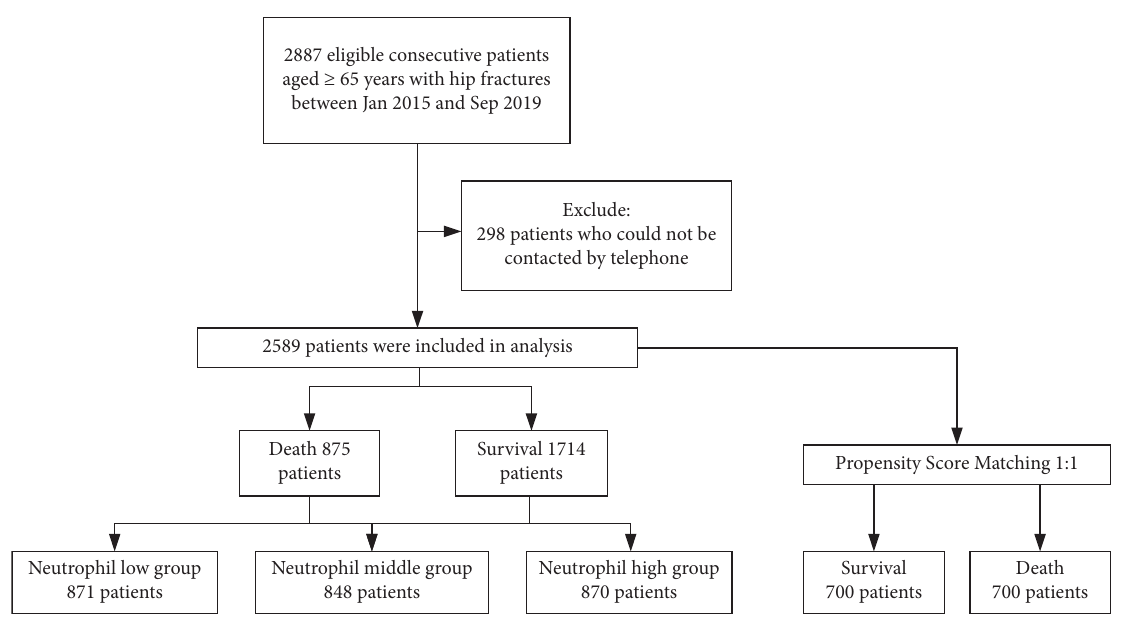
Figure 1: Study fow